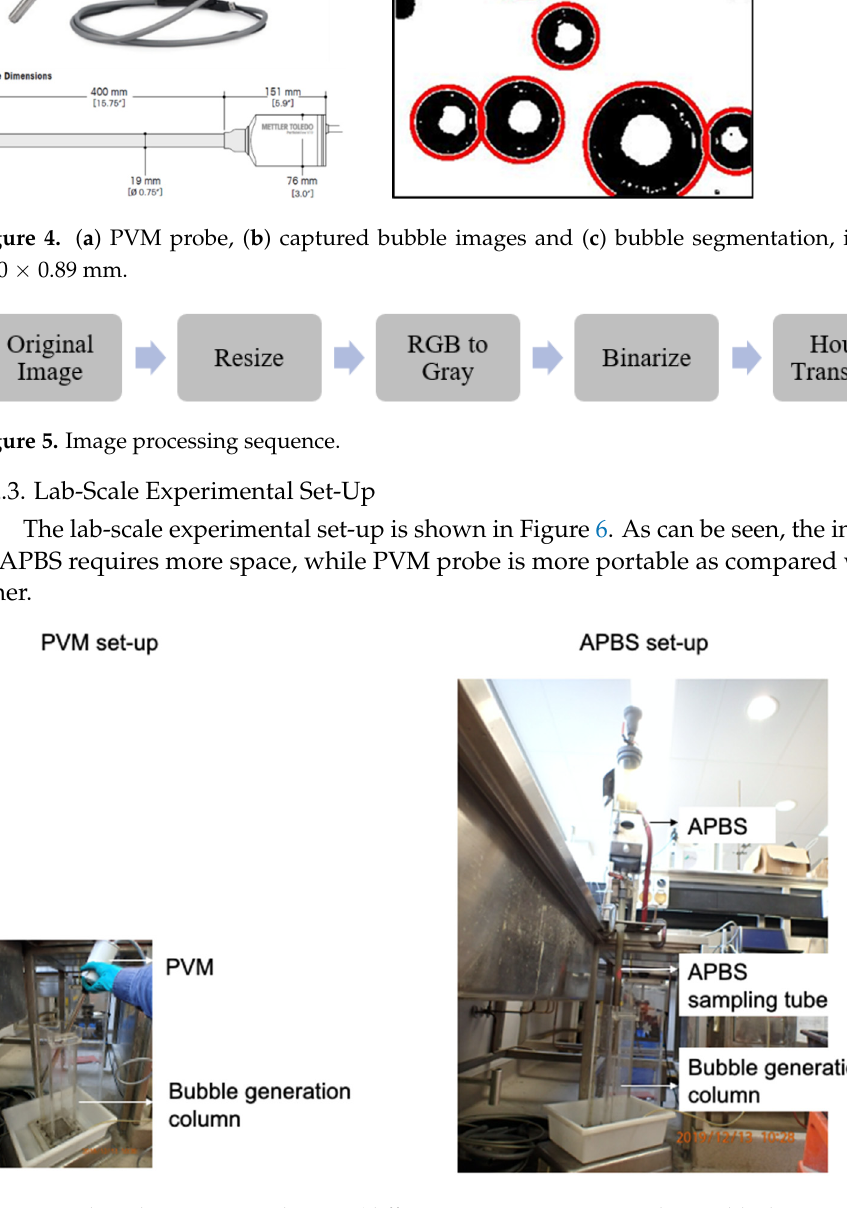
Figure 6. Lab-scale experimental set-up (different size images presented to enable the size comparison between the two sets of equipment).